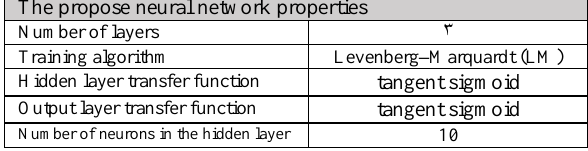
Table 3.Parameters of the proposed MLP